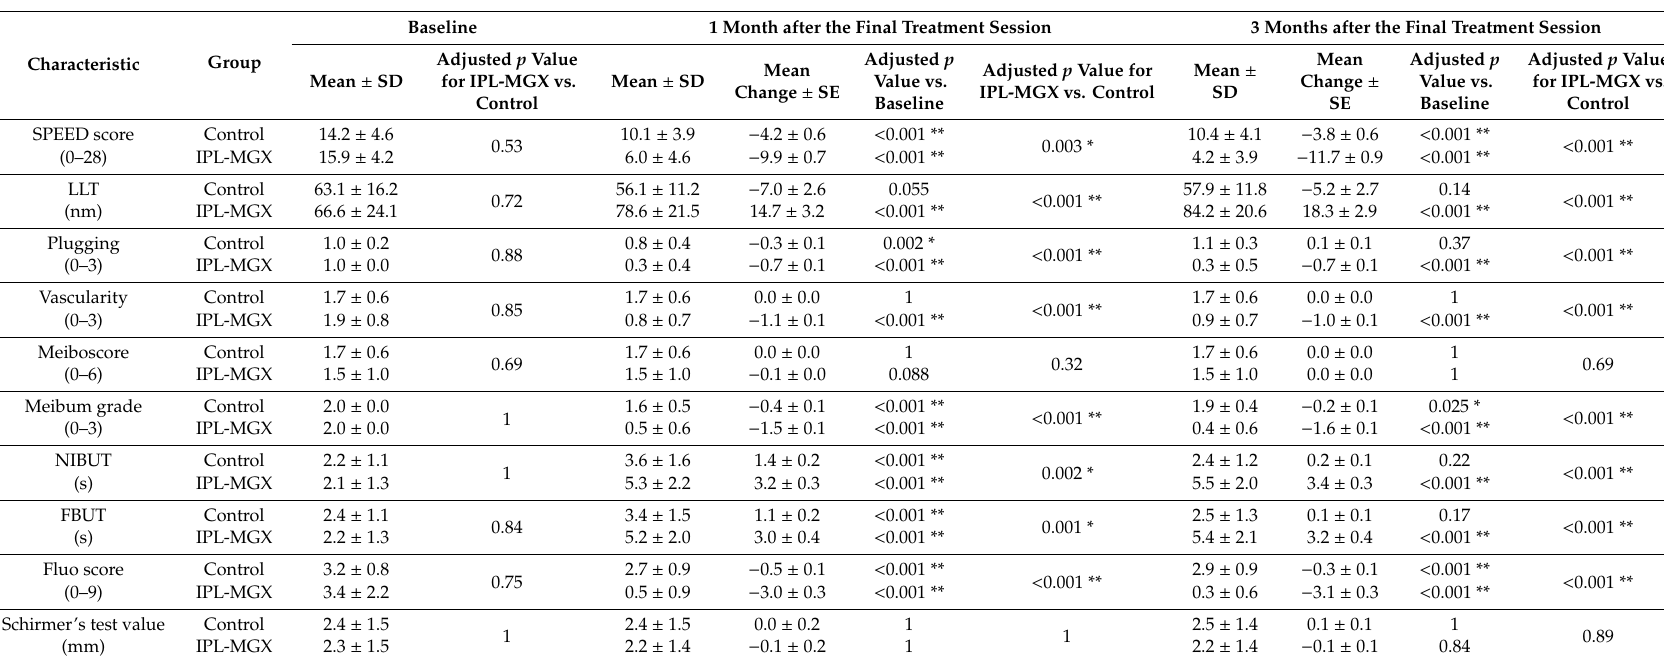
Table 3. Characteristics of the study subjects with aqueous-deficient dry eye and mild meibomian gland dysfunction in intense pulsed light (IPL)-meibomian gland expression (MGX) and MGX (control) groups before as well as 1 and 3 months after the final treatment